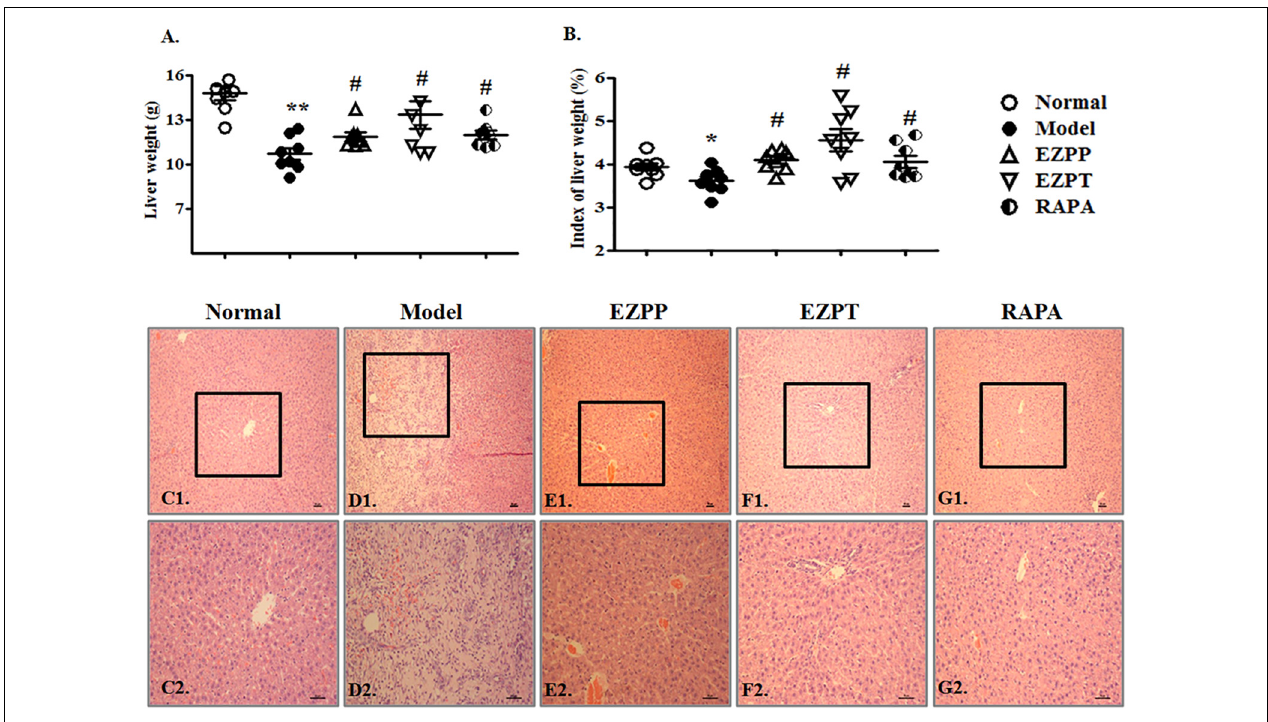
FIGURE 2 | Pathological changes in liver injury induced by 2-AAF/PH. The index of liver weight was measured as liver weight (g)/body weight (g) × 100%. (A) Liver weight; (B) index of liver weight; liver histology is shown in Normal group (C1,C2) , Model group (D1,D2) , EZPP group (E1,E2) , EZPT group (F1,F2) , and RAPA group (G1,G2) . Pathology slides of liver were stained with HE. C1, D1, E1, F1, and G1: bar = 100 µ m; C2, D2, E2, F2 and G2: bar = 200 µ m. Data are expressed as mean ± SEM ( n = 8). ∗ p < 0.05 and ∗∗ p < 0.01 versus Normal group; # p < 0.05 versus Model group.